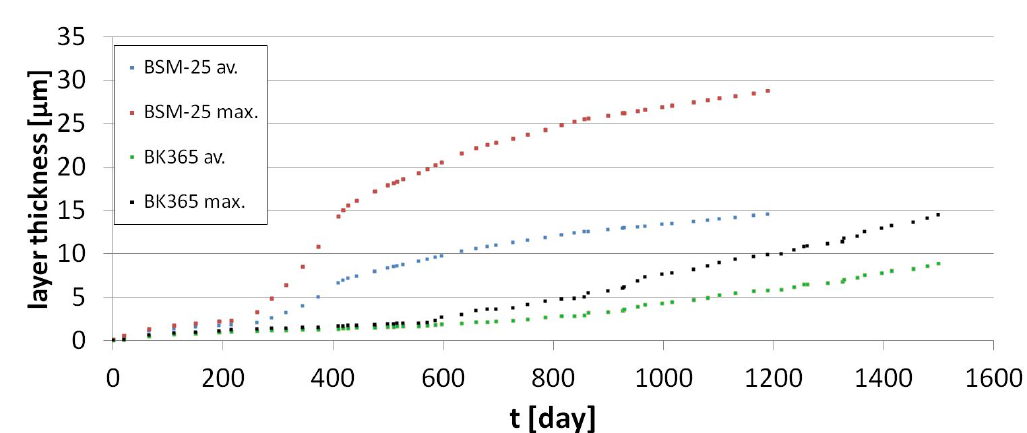
Figure 7. Oxide layer thickness of BSM-25 and BK365